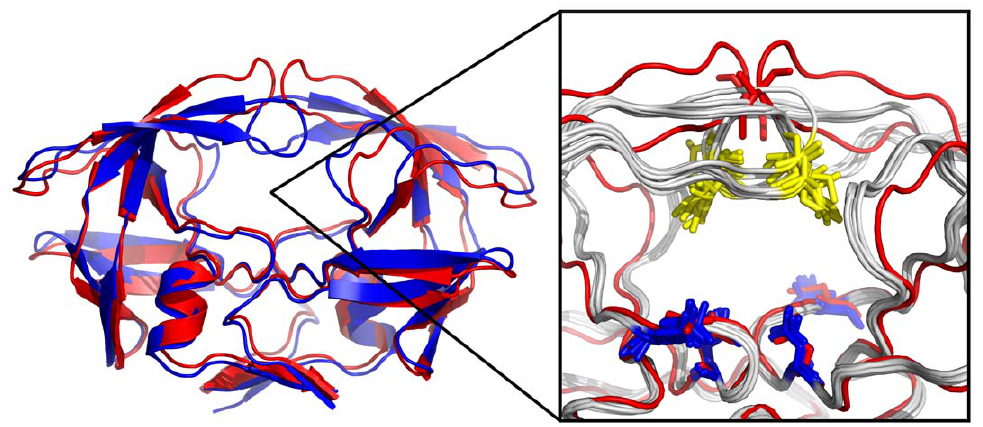
Figure 1. Conformational changes in HIV-1 Protease. Left: Cartoon representation of an unbound (red, pdb ID 3HVP) aligned to a bound receptor structure of HIV-1 protease (blue, pdb ID 7UPJ). Upon ligand binding, the closure of the two flaps narrowing the binding site is clearly visible. – Right: Close-up view of the binding site. Apo HIV-1 protease (red) aligned to 7 different bound forms of HIV-1 protease shown in grey (ligands not shown). Four flexible side chains (yellow: Ile’50 residues and blue: Asp’25 of both monomers of the homo-dimeric protease structure) at the substrate and inhibitor binding site are represented as stick structures (colored red in case of the apo structure).